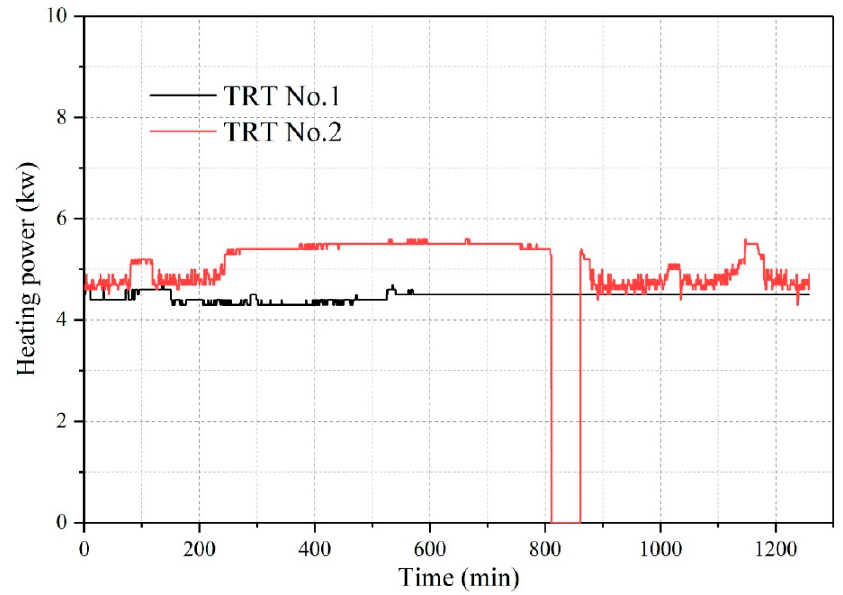
Figure 5. The records of heating power for the thermal response test of two borehole heat exchangers. They show that power input of TRT No. 2 was interrupted at approximately 870 min.